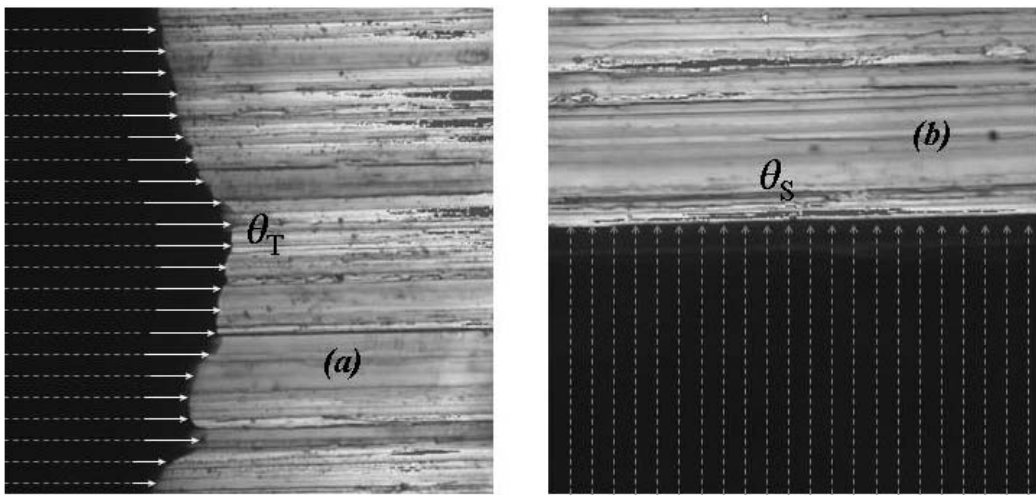
Figure 9. Complete wetting around the contact points where the angles were measured in T direction ( a ), Apparent contact angles measured in S direction correspond to a partial wetting regime ( b ). Measuring length 160